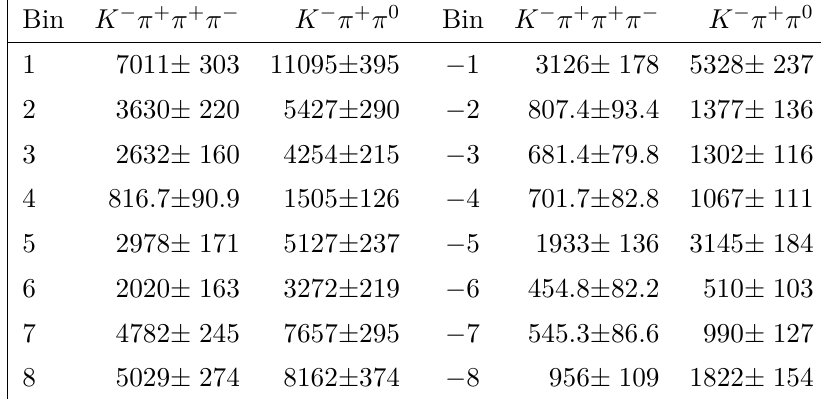
and Y Kππ 0 in bin i of D → K 0 π + π − phase i i S